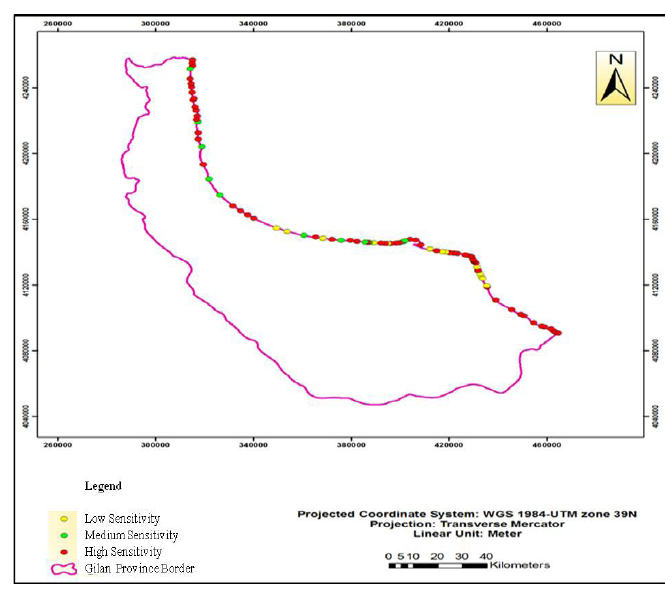
Figure 3. Map of resources used by humans in terms of sensitivity to oil spills